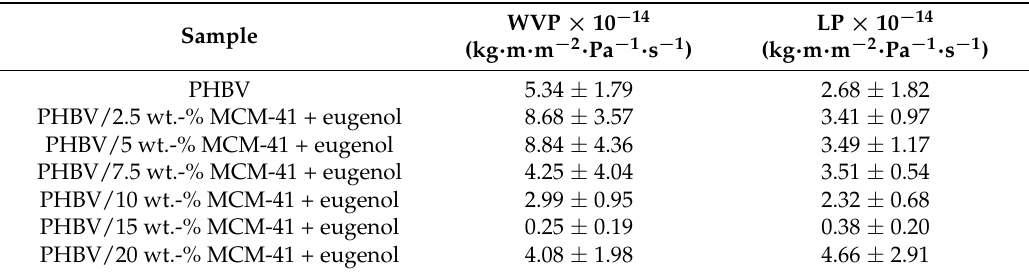
Table 5. Permeability values in terms of water vapor permeability (WVP) and D -limonene permeability (LP) for the electrospun films of poly(3-hydroxybutyrate- co -3-hydroxyvalerate) (PHBV) and PHBV/Mobil Composition of Matter (MCM)-41 with eugenol.